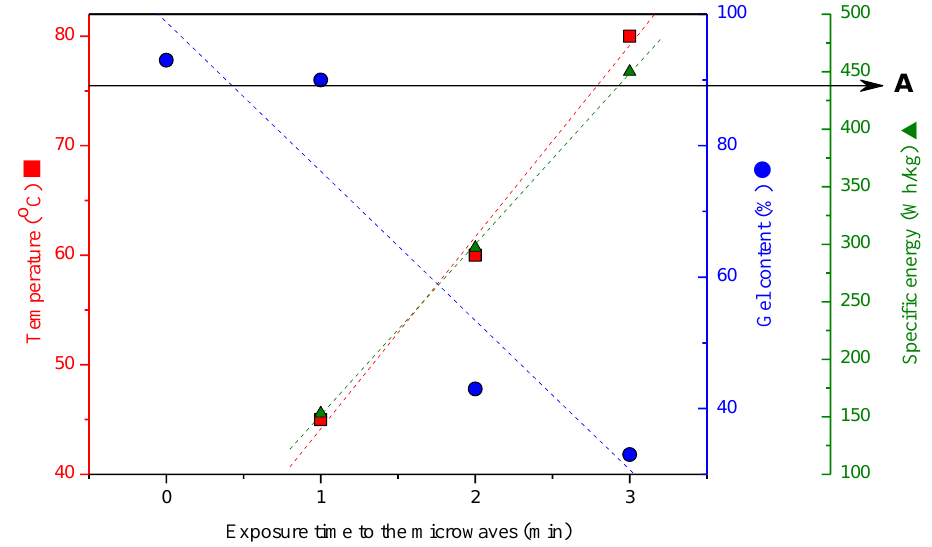
Figure 1. Temperature of the recycled SBR just after its exposure to the microwaves, the gel content, and the corresponding medium microwave specific energy of the devulcanized samples.